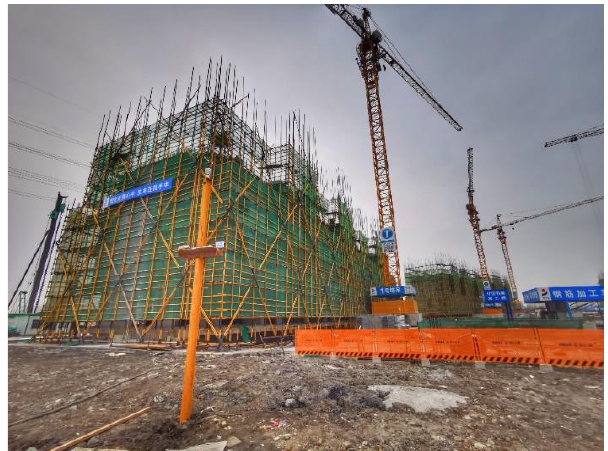
Figure 6. Relative position of anemometer and tower site (Image by Qiang Li).